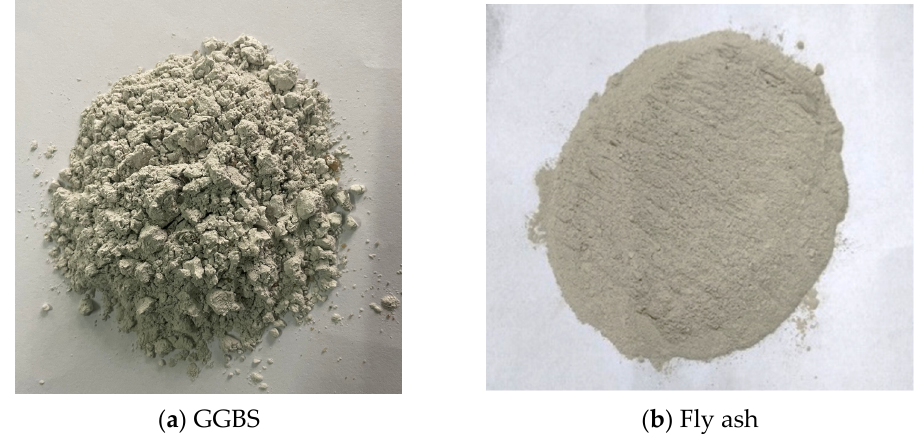
Figure 1. Precursors used in AAC.